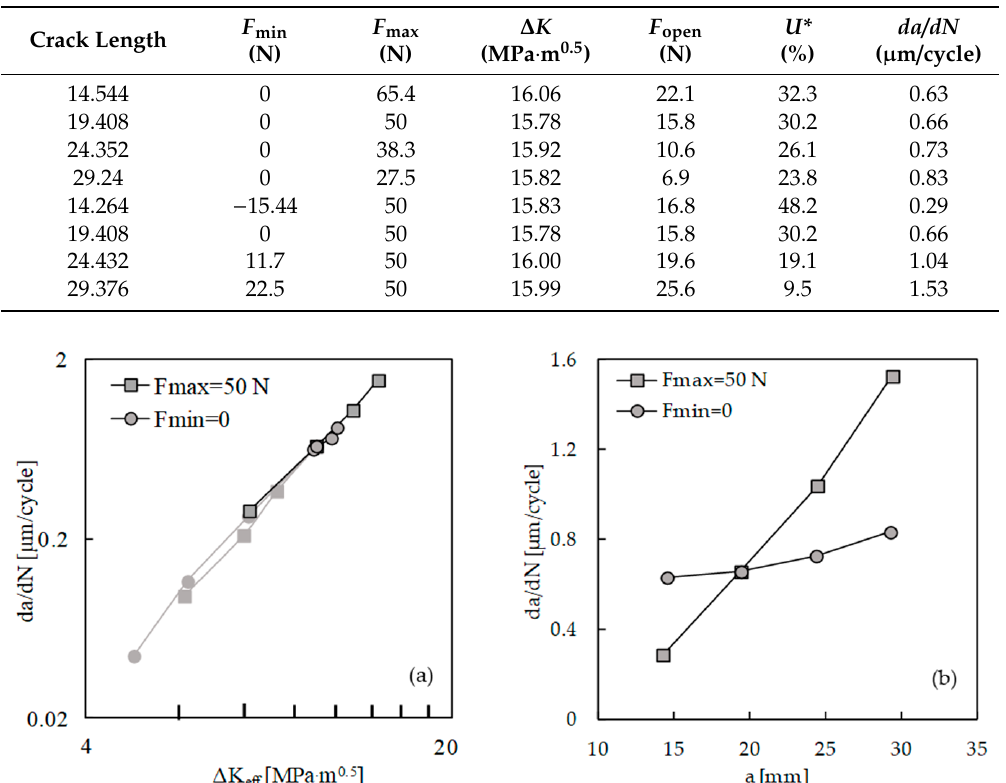
Figure 11. Loading cases with constant Δ K : ( a ) da/dN versus a. ( b ) da/dN versus Δ K eff .